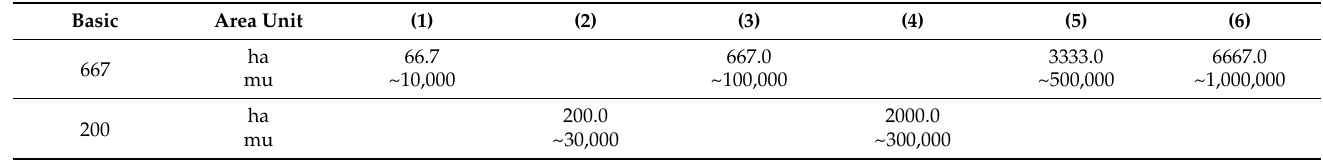
Table 4. Area threshold used in delimitation watersheds via D8